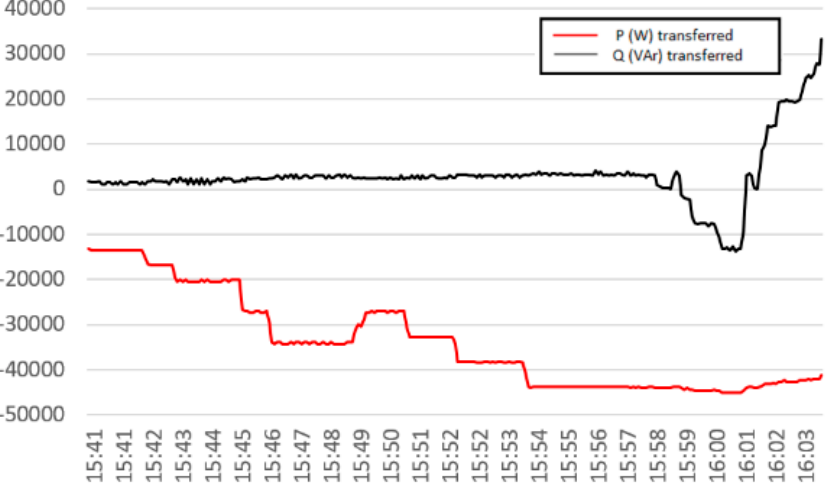
Figure 24. Field test—P and Q transferred between the feeders for phase A.